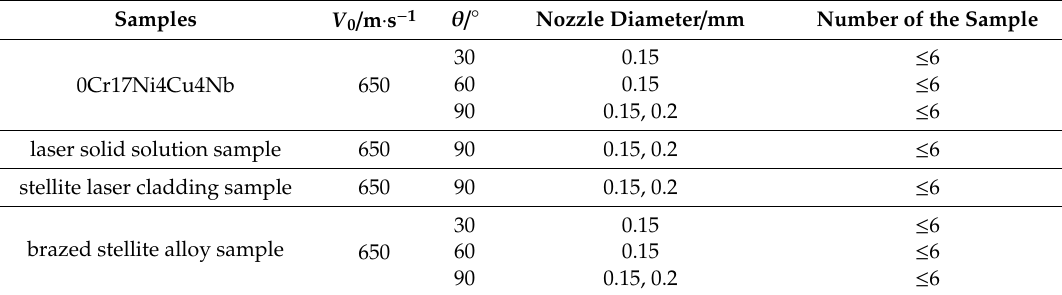
Table 1. Comparison parameters of material resistance to WDE.